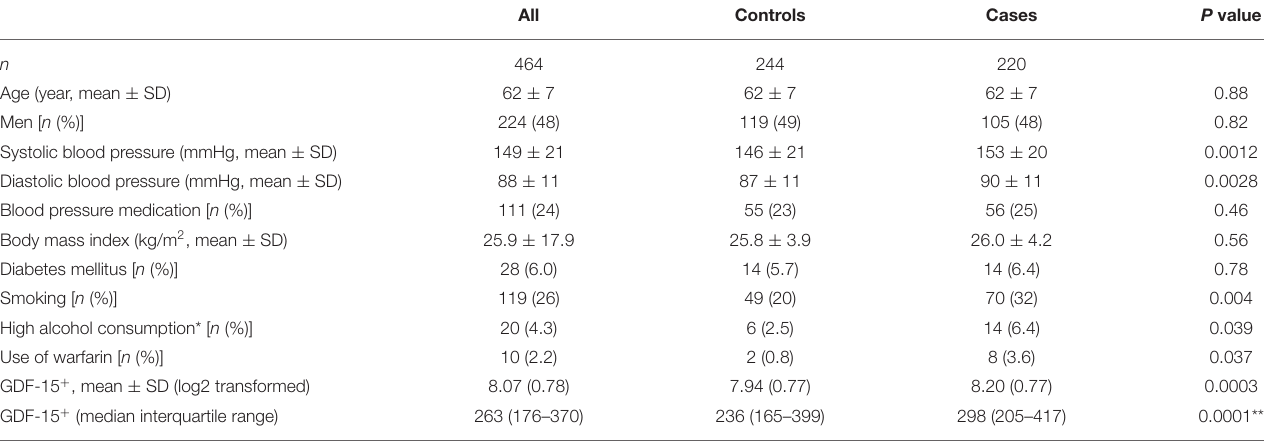
TABLE 1 | Baseline characteristics including levels of GDF-15 in ICH cases and controls. All Controls Cases P value